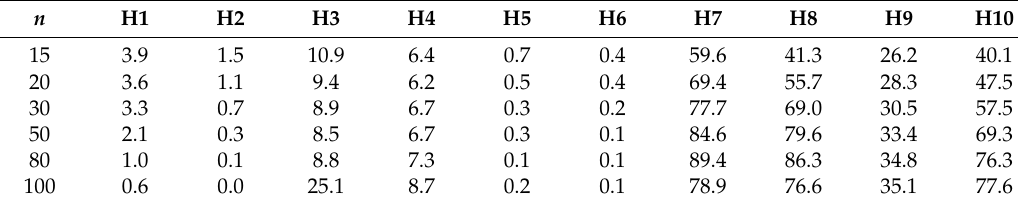
Table 6. Comparison of performances (RPD) of heuristics by number of jobs for Group 2.